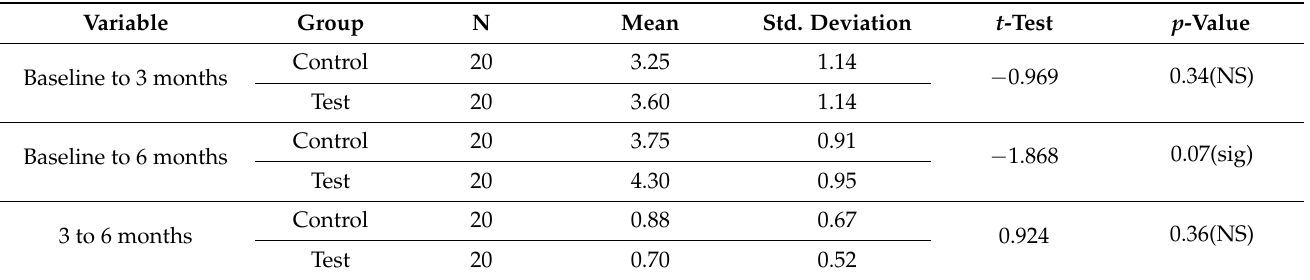
Table 4. Independent t -test for the difference in PPD